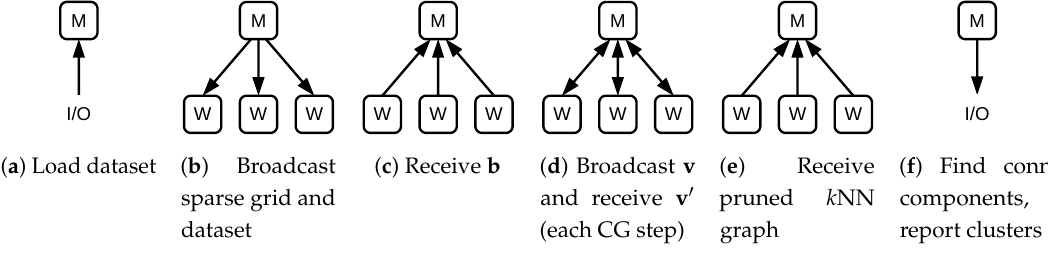
Figure 5. The distributed clustering algorithm from the perspective of the manager node. The (inexpensive) assignment of index ranges is not